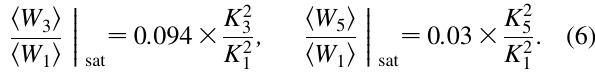
(cid:2) 2 , for the 3rd (solid =K h 1